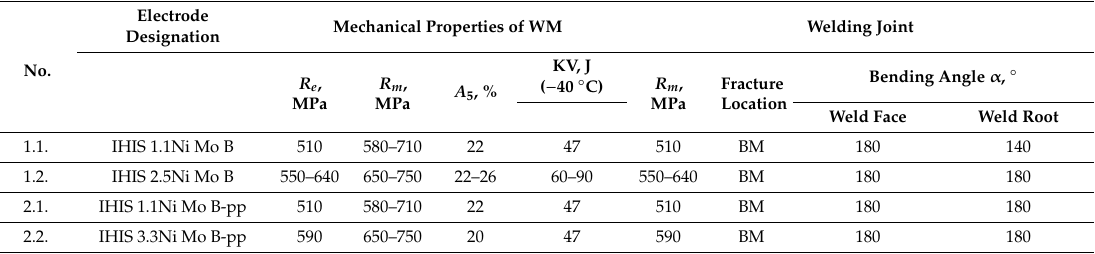
Table 5. Type of the applied electrode, the number of the welded sample, heat input, and WM mechanical properties.